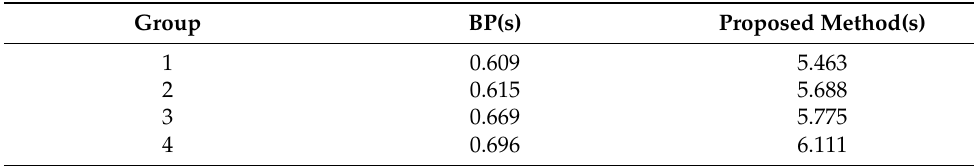
Table 3. Reconstruction time.